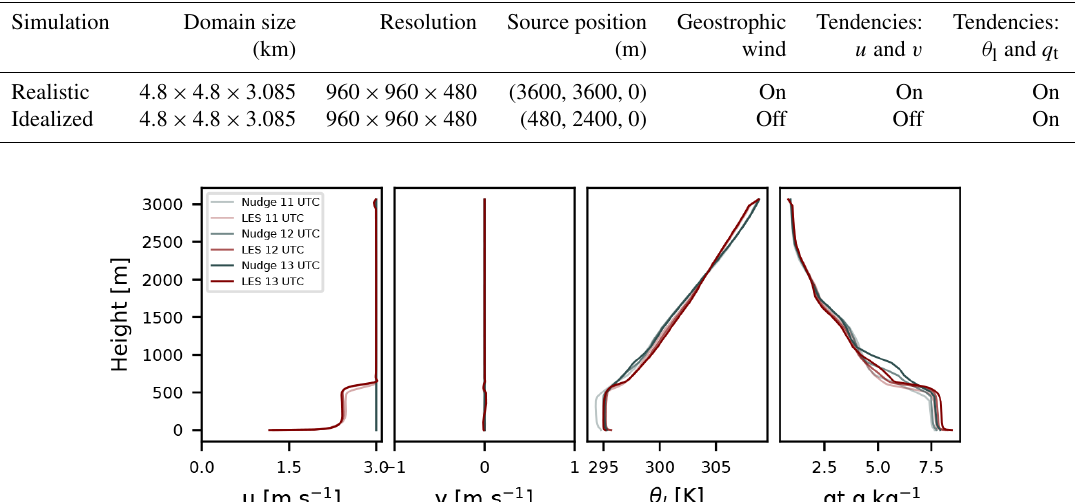
Table 1. The specifics of the two performed simulations. The first row shows the setup of the simulation with highly turning mean wind, and the second row shows the setup of the simulation with the mean along the x axis.